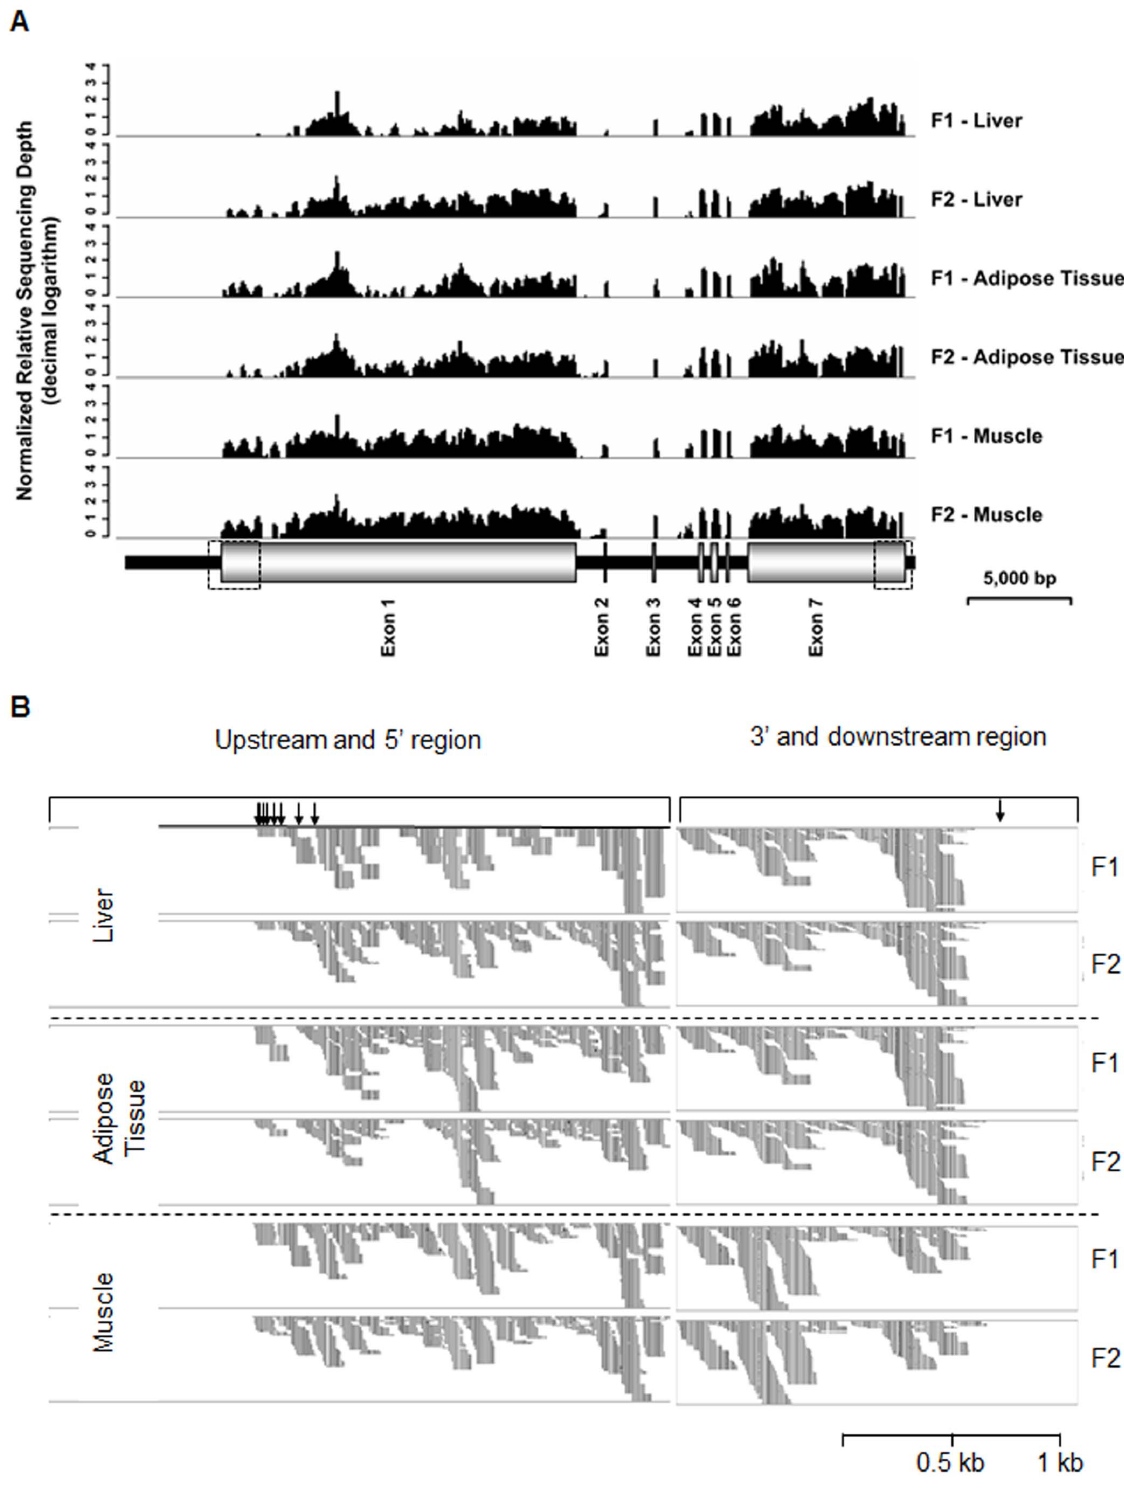
Figure 3. Alignment of Illumina reads to the porcine XIST gene model. (A) Alignment of Illumina reads to the porcine XIST gene locus. Six Illumina reads from three tissues (liver, abdominal fat, and longissimus dorsi muscle) of two female pigs (F1 and F2) were aligned to the entire porcine XIST gene including introns and exons. Small peaks between exon 3 and 4 were identified to be non-specific alignment of reads. The diagram is scaled. The two dotted boxes indicate upstream/5 9 and 3 9 /downstream regions of the XIST gene, respectively. (B) Alignment of Illumina reads to upstream/5 9 and 3 9 /downstream regions. Arrows in the upstream and 5 9 region indicate the transcription start sites (TSS) of the porcine XIST gene identified by 5 9 RACE. The arrow at the 3 9 and downstream region indicates the end of the porcine XIST RNA identified by 3 9 RACE.